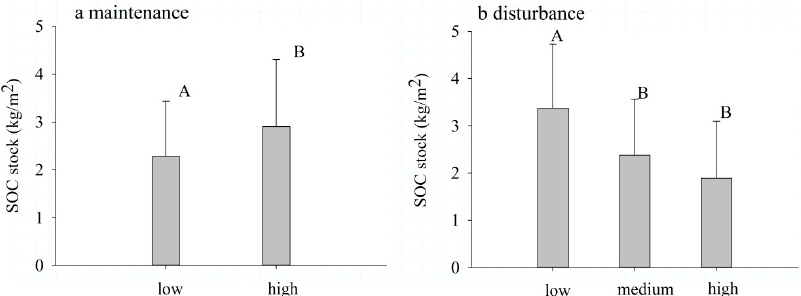
Figure 4. Differences in SOC stock between ( a ) maintenance and ( b ) disturbance intensity classes. Thirty-six plots for low- and high-maintenance classes, respectively, and 18, 48 and 6 plots for low-, medium- and high-intensity disturbance groups, respectively. Different letters denote significant differences among maintenance or disturbance intensity types at p < 0.05.